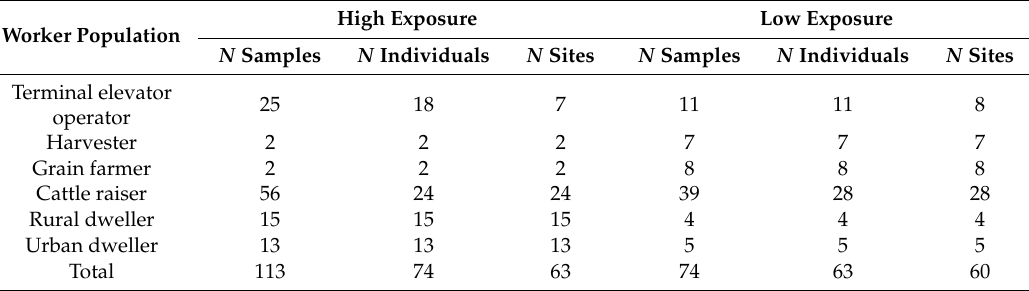
Table 1. Number of samples successfully amplified and sequences for each environment. Worker